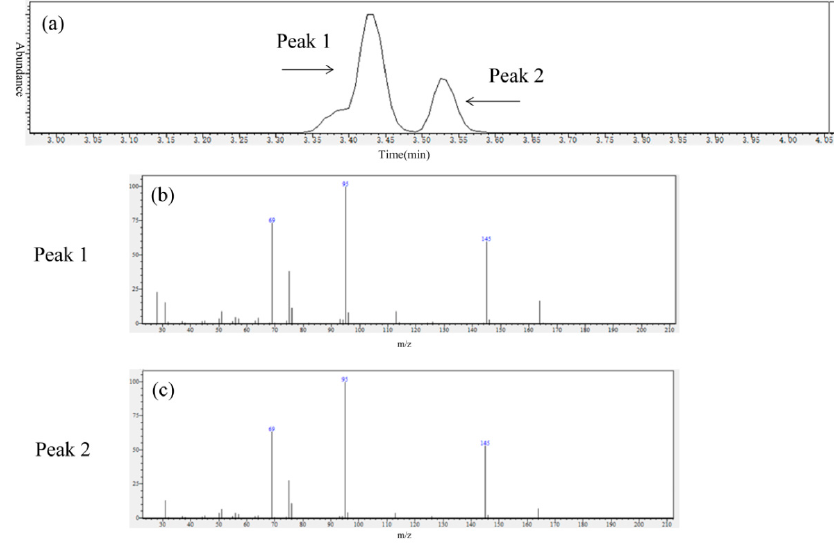
Figure 2. GC–MS results of gas collected by gas pocket. ( a ): Gas chromatogram of gas; ( b ): Mass spectrum of Peak 1; ( c ): Mass spectrum of Peak 2).